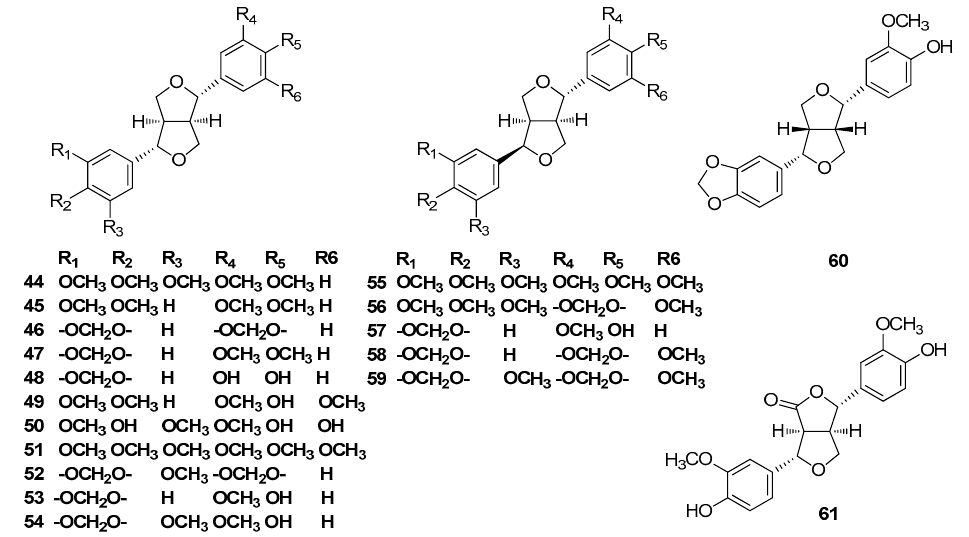
Figure 5. Chemical structures of 7.9’,7’.9-diepoxylignans.